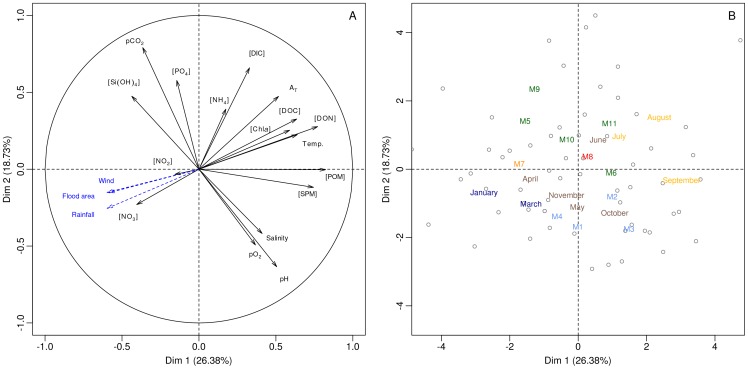
Biplots of water physical and chemical characteristics with scaling highlighting variable correlations (A) and mapping of individual samples (B).Rainfall, wind velocity and total flooded surface area are plotted as supplementary variables (blue arrows and text) on A. Text representing the centroids for each site and month are shown on B. Colours of sites and months represent regions (see Fig. 1) and seasons, respectively.